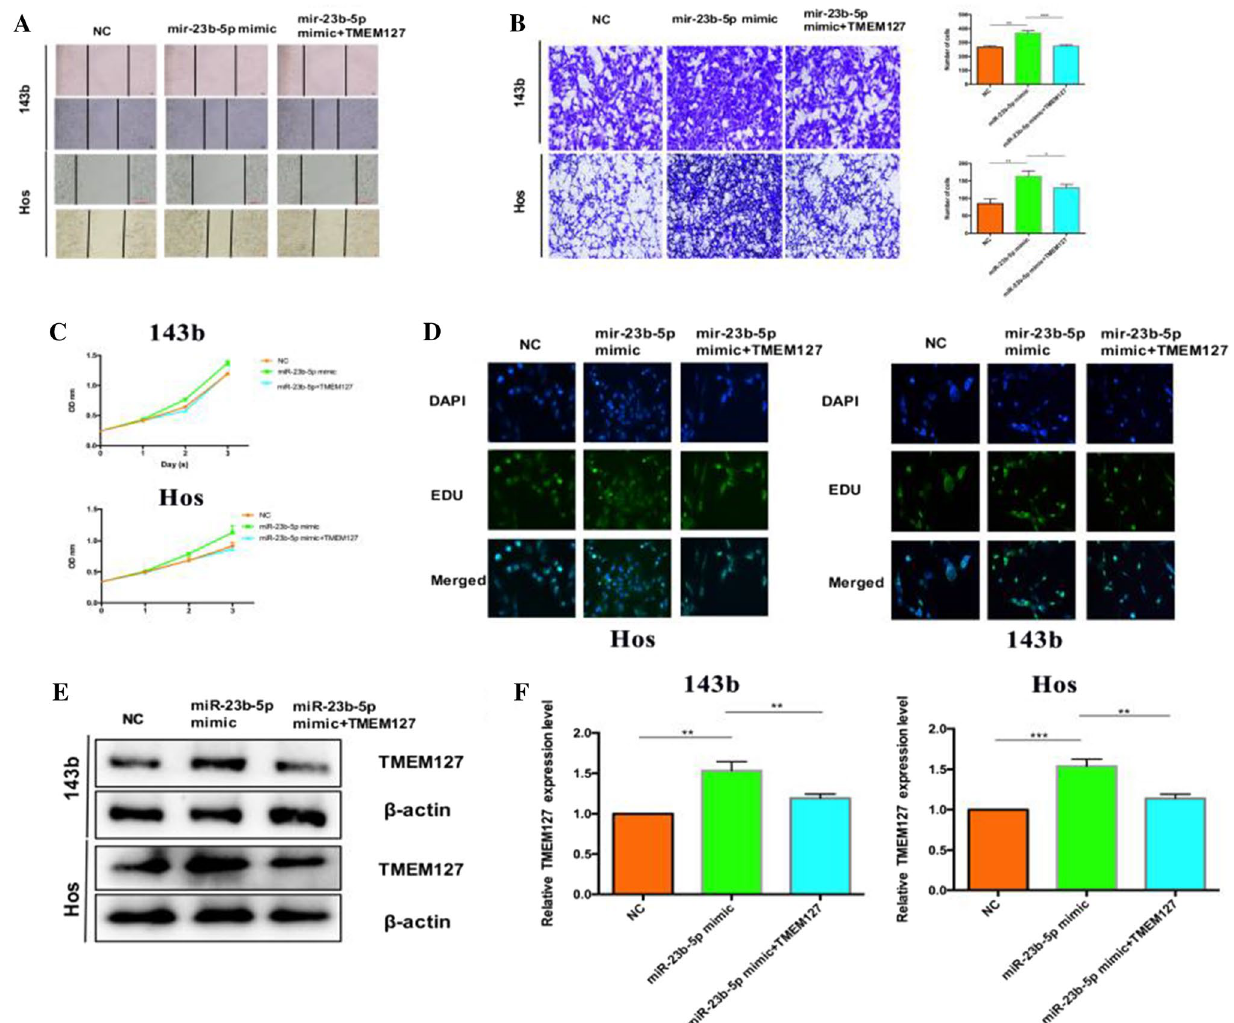
Fig. 5 miR-23b-5p targets TMEM127 to promote OS progression. A The metastatic ability of cells co-transfected with miR-23b-5p and TMEM127 was detected by wound healing assay. B The invasive ability of cells co-transfected with miR-23b-5p and TMEM127 was detected by transwell assay. C CCK-8 detection of cell viability after co-transfection of miR-23b-5p and TMEM127. D The cell proliferation kit was used to analyze the changes in the proliferation ability of OS cells. E The protein expression levels of TMEM127 in OS cells after miR-23b-5p trans- fection alone and miR-23b-5p co-transfection with TMEM127 were detected by western blot. F The mRNA expression levels of TMEM127 in OS cells after miR-23b-5p transfection alone and miR-23b-5p co-transfection with TMEM127 were detected by qRT-PCR. Results are shown as mean ± SD from three independent experiments. **P <